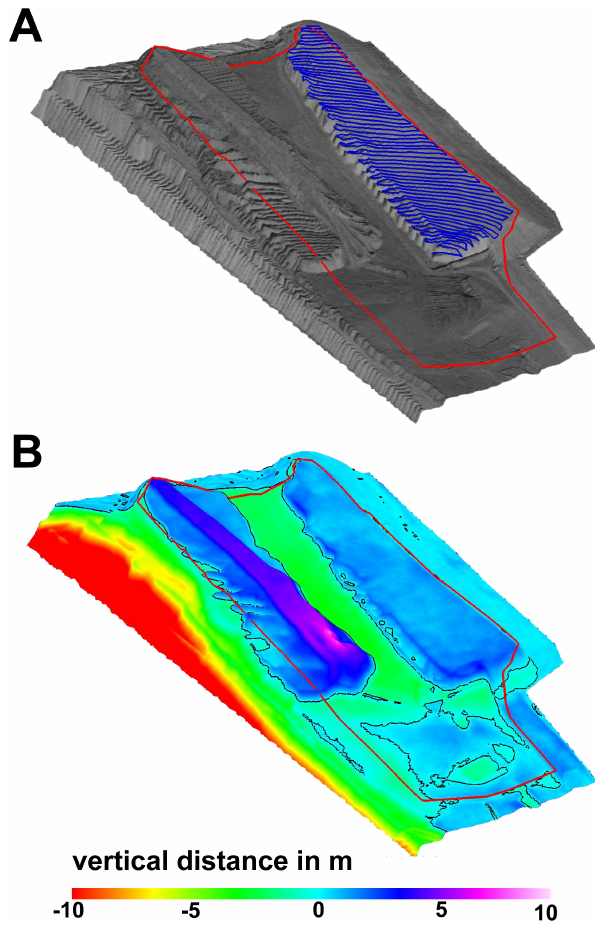
Fig. 8. (A) Location of spoil ridges (blue line) obtained from man- ual digitisation of aerial images and combined with the surface model of the Chicken Creek catchment (shape indicated by the red line) from the construction phase in October 2004, and (B) verti- cal distances between the surface model of the construction phase (October 2004) and the surface model from November 2005, when construction was finished. The volume difference obtained from the comparison of surface models allowed to calculate volumes of the dumped sediment masses and to derive mean spoil cone